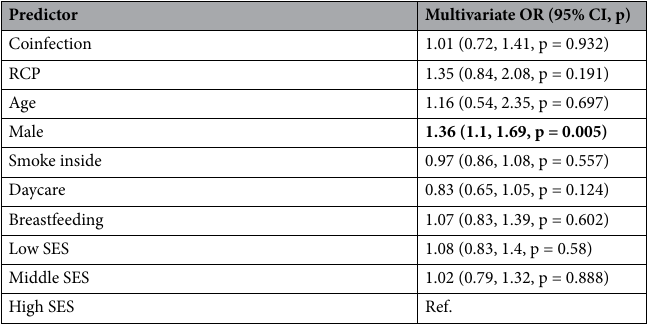
Table 2. Predictors of clinical severity. Table gives the adjusted odds ratios of being a severe clinical case (CSS > 3 ) by coinfection status (more than 1 detection), RCP (yes/no), per year of age, Male sex (male vs. female), smoking in the home (yes/no), attending daycare (yes/no), breastfeeding status (yes/no), and socioeconomic status (SES; low and middle vs. high). The model is additionally adjusted for calendar year and month of year. Estimates displayed in bold face indicate statistical significance